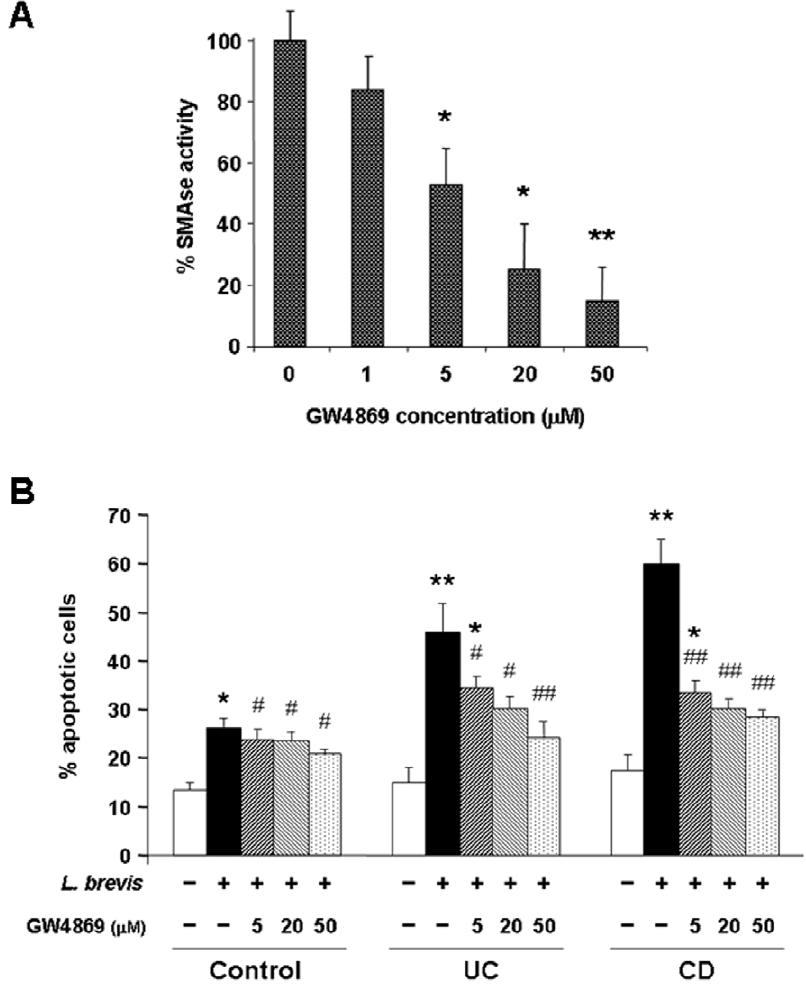
Figure 8. Specific inhibition of L.brevis -induced cell apoptosis by GW4869. A) L. brevis sonicates were exposed to increasing concentrations of GW4869. SMAse activity of each bacterial sonicate is expressed as relative SMAse activity, assigning an arbitrary value of 100 to the mean SMAse activity of L. brevis sonicates. Each bar represents 3 separate experiments. * p , 0.05 and ** p , 0.01 vs. no GW4869. B) Control LPMC were left alone or exposed to L. brevis sonicates previously treated with different doses of GW4869 for 24 hours, after which the percentage of apoptotic cells was assessed. Each bar represents 4 separate LPMC isolates. * p , 0.05 and ** p , 0.01 vs. no bacteria; # p , 0.05 and ## p , 0.01 vs. no GW4869.